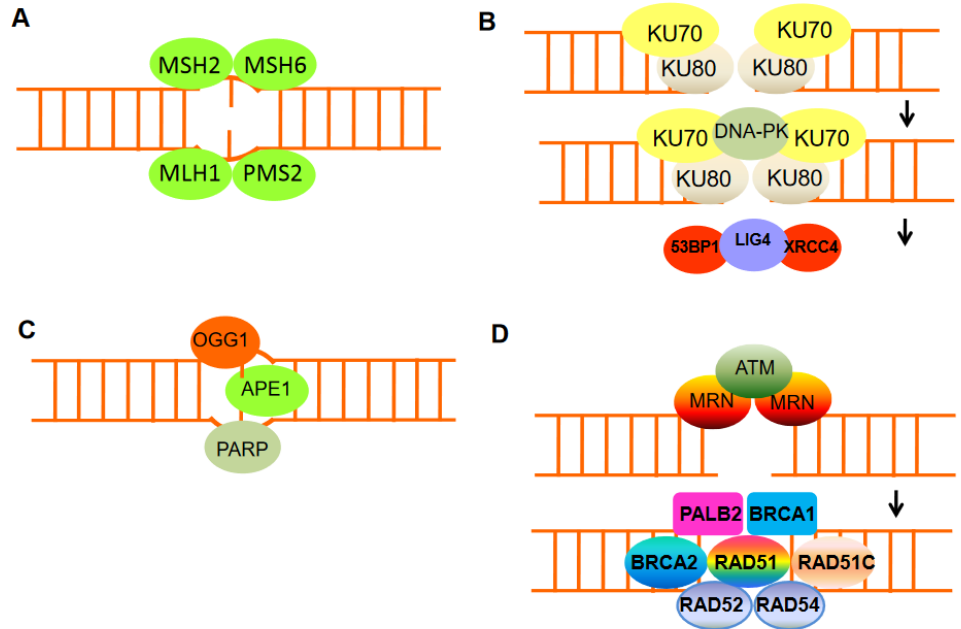
Figure 2. The mechanisms of DNA damage repair. ( A ) Mismatch repair proteins localize and repair mismatched bases. ( B ) Nonhomologous end-joining (NHEJ) requires a nuclease to resect damaged DNA, DNA polymerases to fill in new DNA, and a ligase to restore integrity to the DNA strands. The Ku bound to the end of the DNA can be considered as a Ku:DNA complex, which is a node where the nuclease, polymerase, and ligase of NHEJ can dock. DNA-PK has a molecular weight of 469 kDa and contains 4128 aa. It is the largest protein kinase in biology and is the only protein kinase that is specifically activated by binding to the ends of double-stranded DNA with multiple end configurations. Activated DNA-PK stimulates the ligase activity of XRCC4: DNA ligase 4. ( C ) Base excision repair can remove damaged DNA bases, e.g., by oxidation, using damage-specific DNA glycosylase, in the case of oxidizing guanine, 8-oxoguanine DNA glycosylase 1 (OGG1). ( D ) DNA double-strand break repair by homologous recombination (HR) can only be active in late S or G2 phases of the cell cycle when sister chromatid templates are available. HR includes DNA excision through MRN, homologous pairing and strand exchange through RAD51 and RAD52, Rad51c, Rad54, and BRCA1–PALB2, and DNA